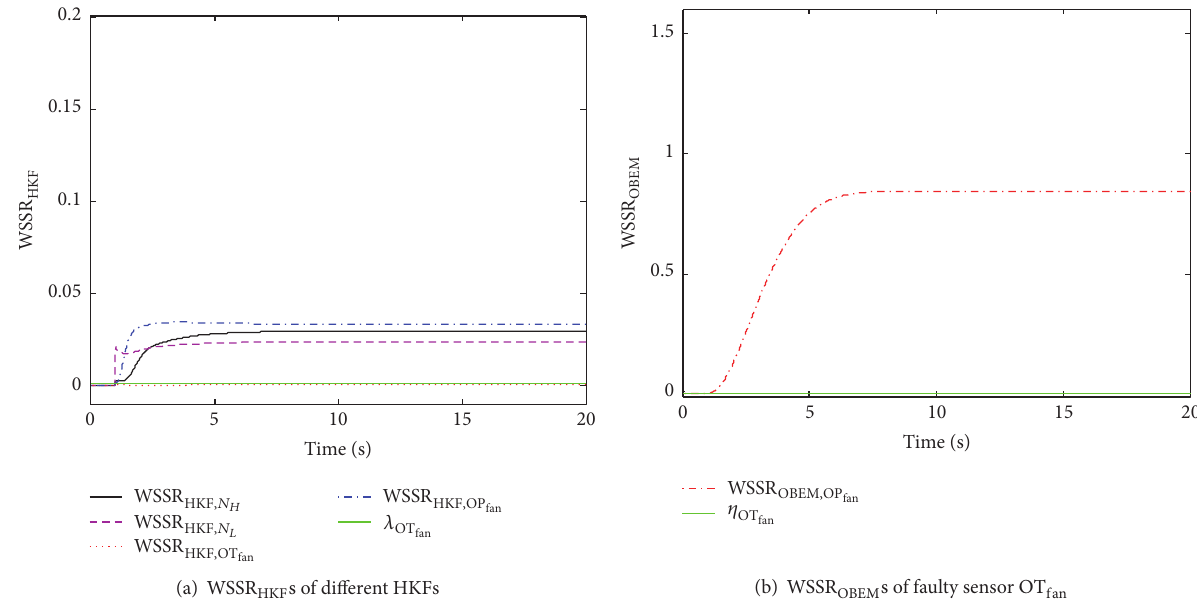
Figure 9: WSSRs of the